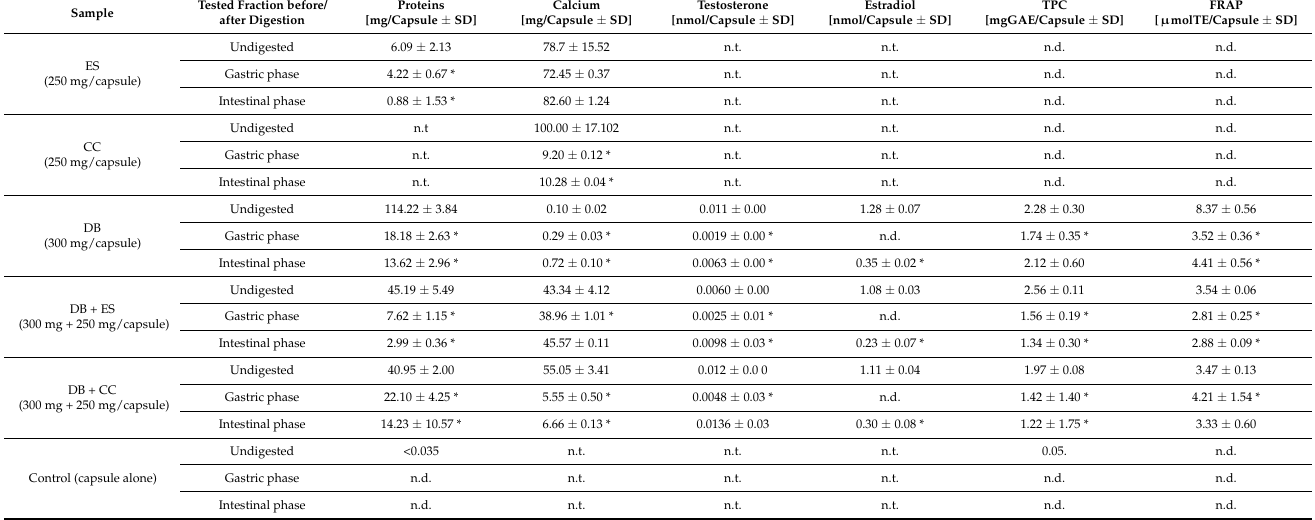
Table 4. Comparison of the bioaccessibility of protein, calcium, testosterone, estradiol, polyphenolic compounds, and antioxidants in the tested fractions.